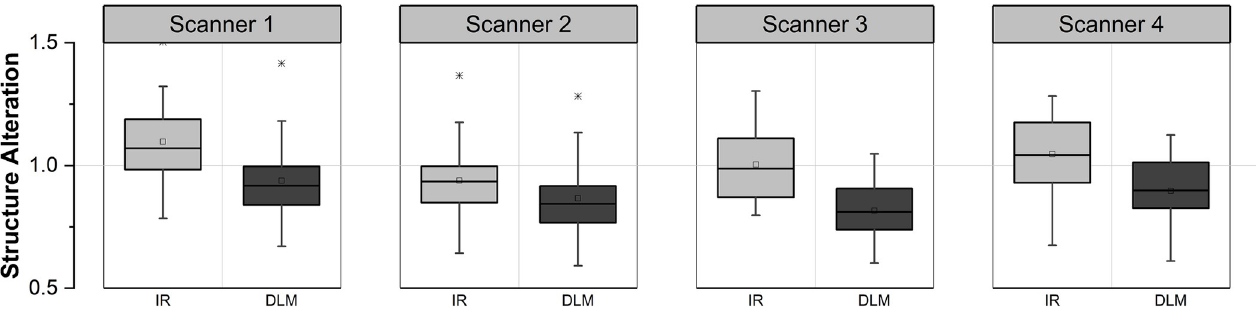
Fig 12. Box plots compare structure alteration index of IR and DLM